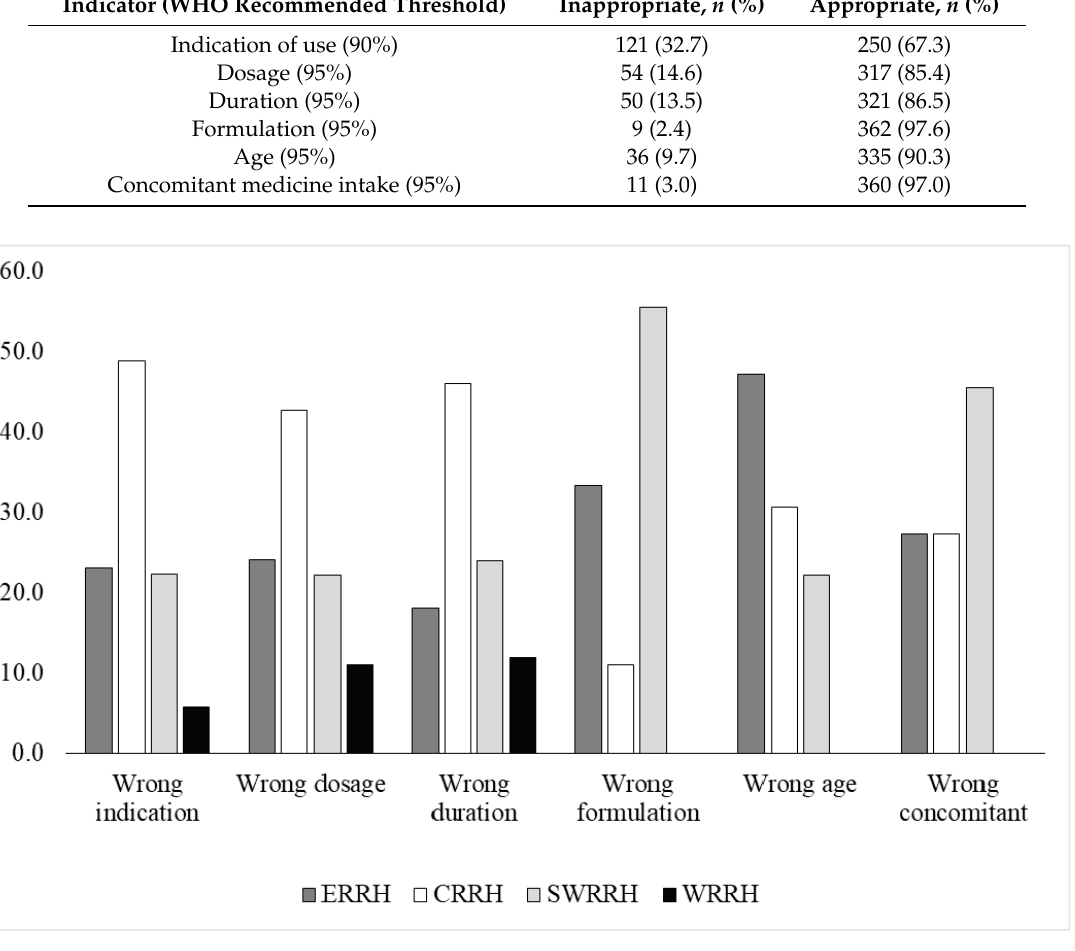
Table 3. Distribution of the reasons for inappropriate use of levofloxacin in 371 studied prescriptions (100%) according to the British National Formulary and also WHO recommended indicators and thresholds (see Methods).